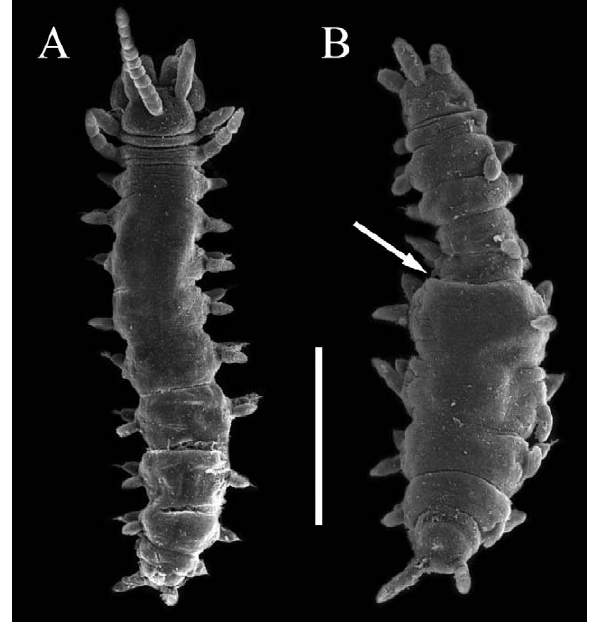
Fig . 4. – SEM micrographs of Haplosyllis aplysinicola n. sp. from Belize A, juvenile resulting from sexual reproduction. B, juvenile probably resulting from asexual reproduction; arrow indicates the origin of regenerating anterior region. Scale bars A (230 µm), B (150 µm). Personal collection D. Martin.